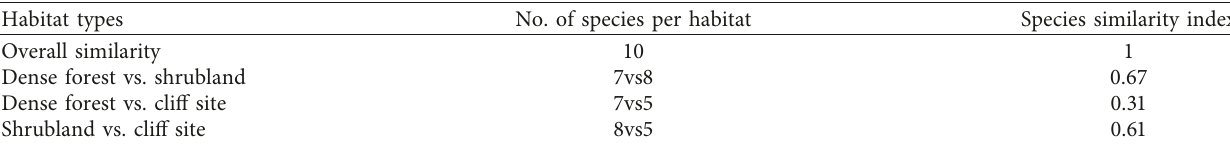
Table 7: Similarity index of wild mammals’ species among the three habitat types of Tiski